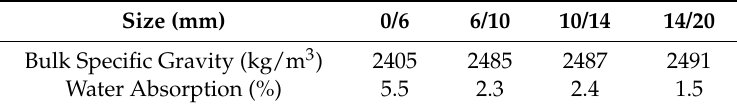
Table 2. Physical properties of virgin aggregates.